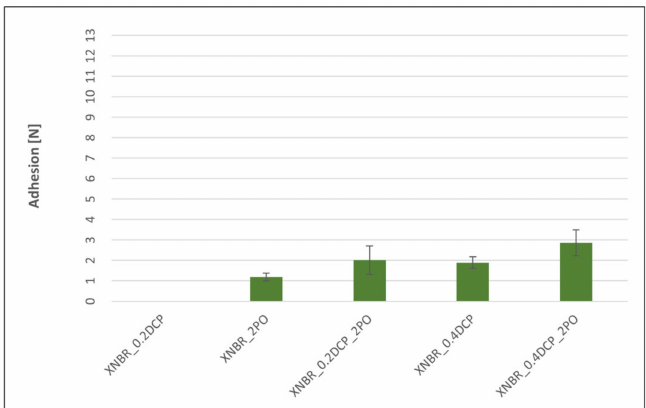
Figure 16. Influence of the modified resin addition on adhesion between peroxide XNBR vulcanizates and silver wires (missing bars indicate the lack of